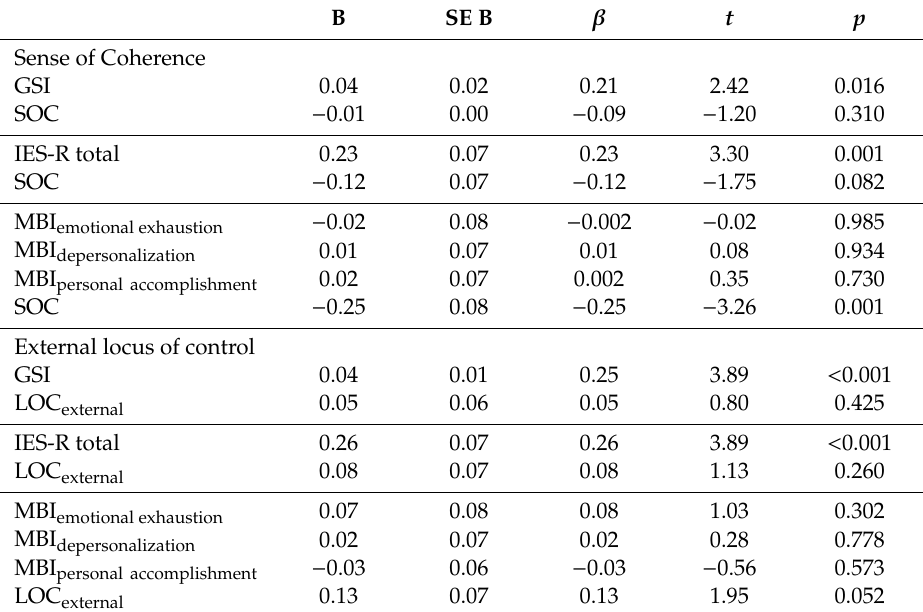
Table 3. Multiple regression results for the prediction of attachment to pets (LAPS total